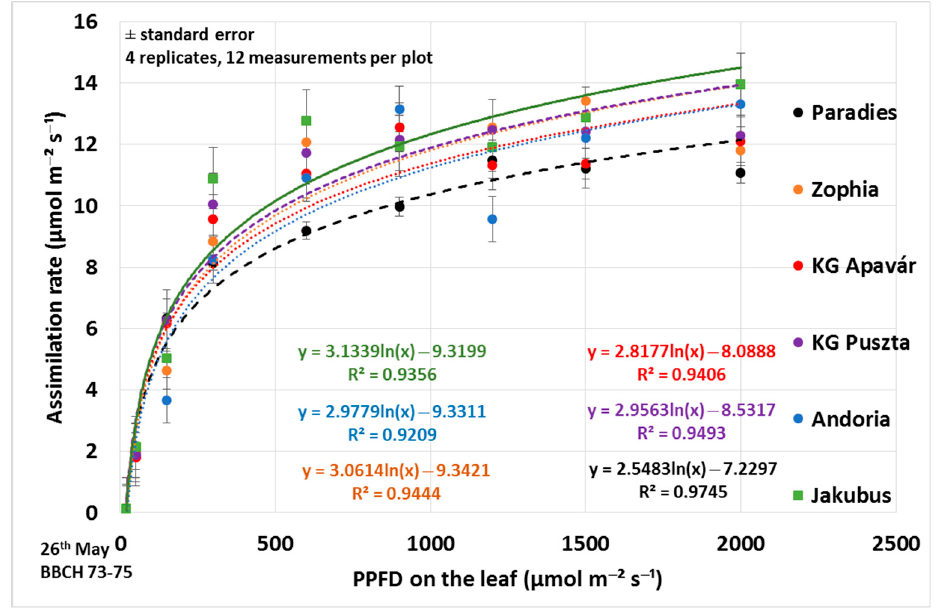
Figure 4. Assimilation rate light curves of winter barley cultivars, 26 May (BBCH 73 − 75), N 90 P 45 K 50 (Debrecen, 2020) 4 replicates, 12 measurements (2 leaves, 6 recordings per leaf). Barley cultivars’ assimilation rates were similar at the low PPFD levels, but there are differences at higher light levels. PPFD: photosynthetic photon flux density.